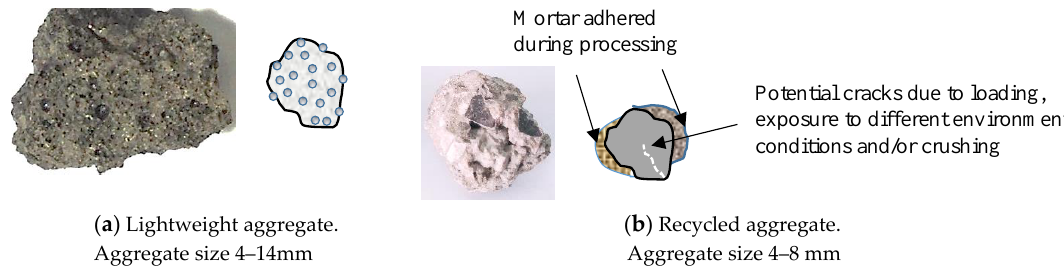
Figure 1. Schematic of lightweight and recycled aggregate particles.